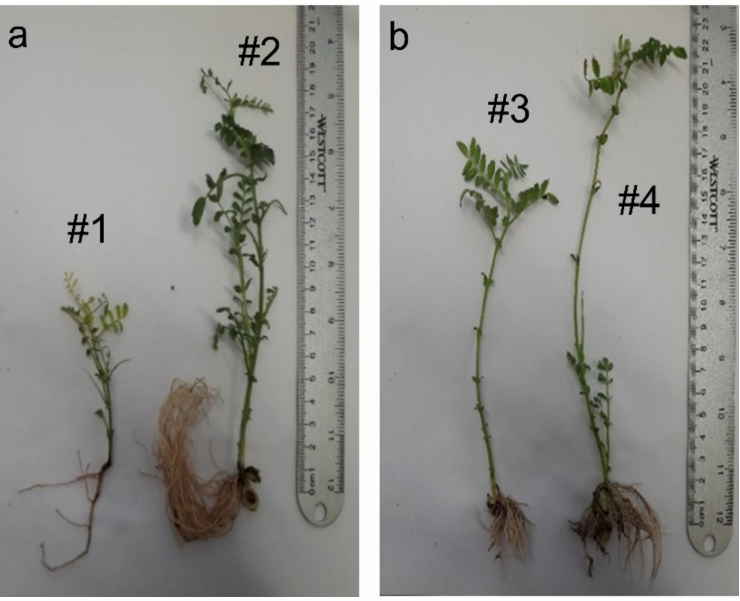
Figure 1. Photos of typical C. arietinum seedling of the control group (#1 in frame ( a )) and the sample treated with: Au NPs (#2 in frame ( a )) and with CNTs (#3 and #4 in frame ( b )) (Pictures taken by F.